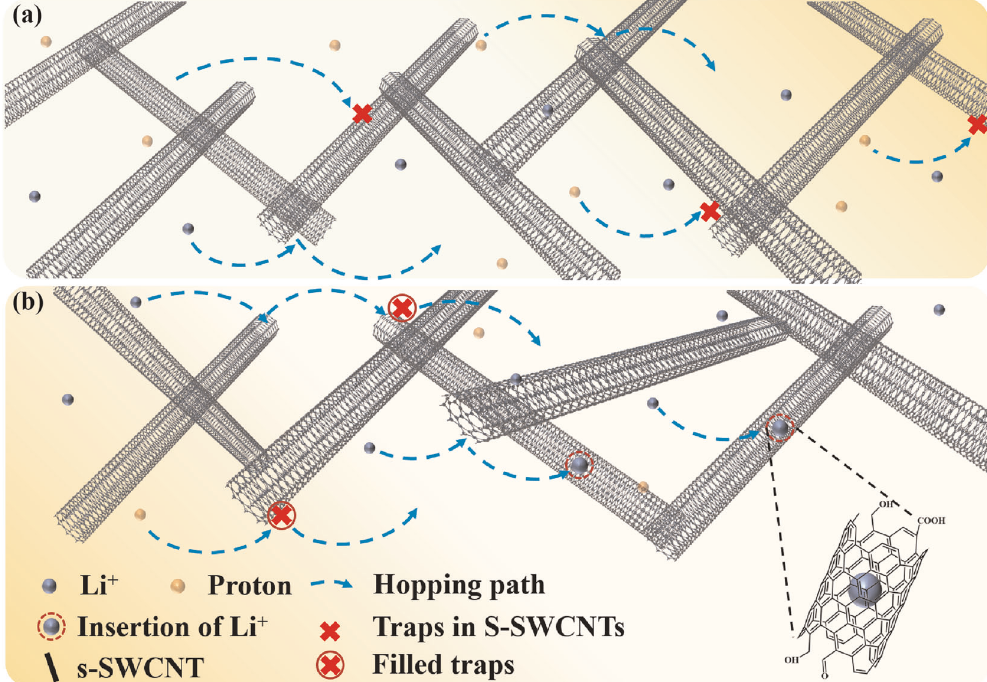
Fig. 3 The schematic diagram for the working mechanism of the arti fi cial synapse. a In low-voltage region, the hopping of carriers through functional groups and their trapping in the trapping-sites through topological defects. b In high-voltage region, the intercalation of Li + in the s-SWCNTs occurs, which leads to a reduction in carrier concentration and mobility.